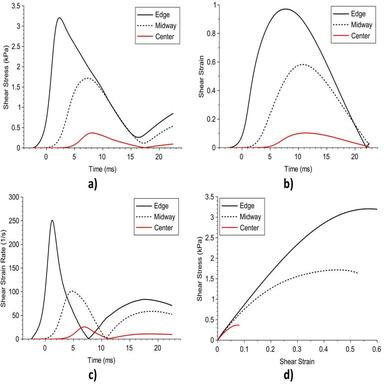
a) Shear stress, b) shear strain and c) rate of shear strain at three locations from the edge to the center of the gel block. d) Stress-strain relationships at an early stage of impact.